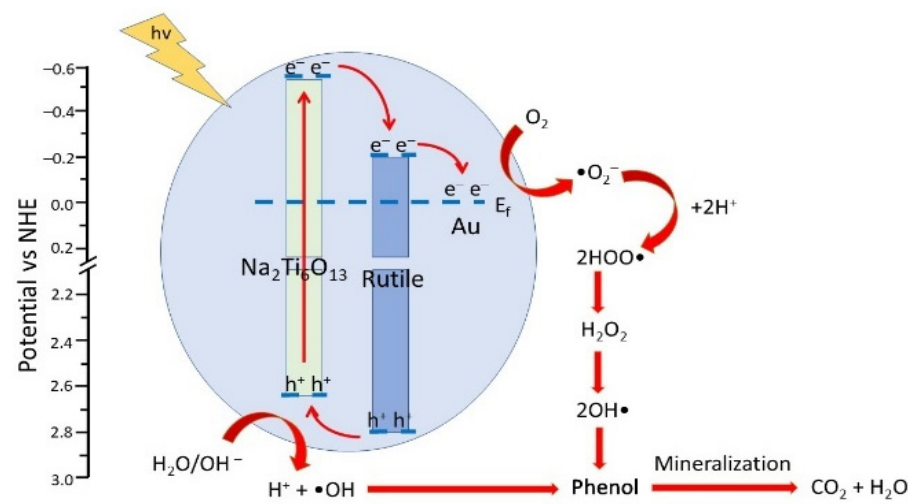
Figure 9. Photocatalytic mechanism of phenol degradation by Au/TiO 2 /NTO